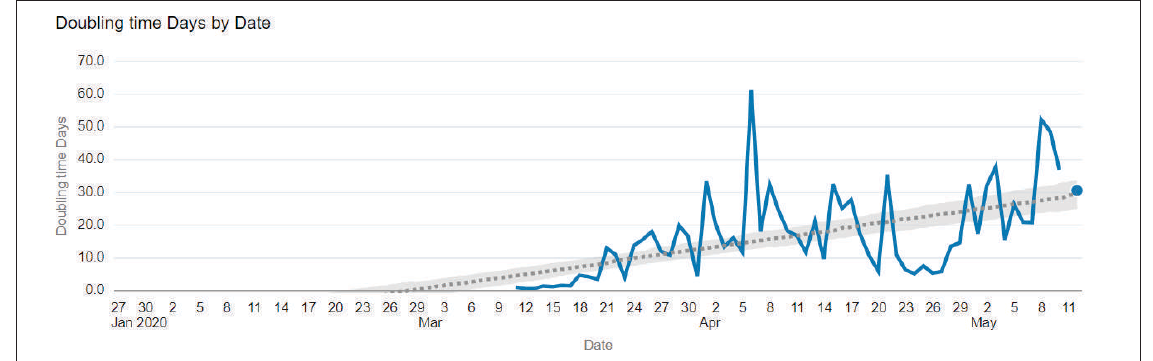
Figure 2: Doubling rates in Sri Lanka